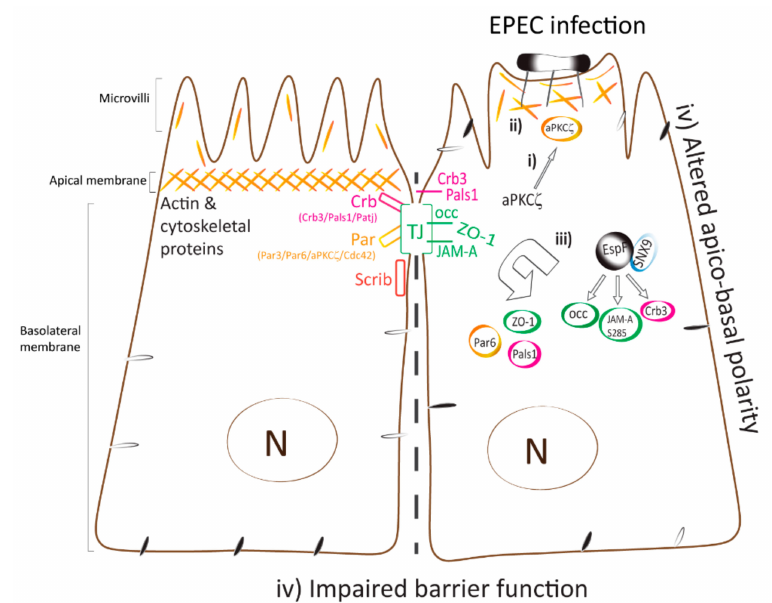
Figure 7. Model displaying the temporal mislocalization of aPKC ζ leading to the dismantling of polarity and TJ complexes. Polarized epithelial cells consist of the apical membrane facing the lumen and the basolateral domain in contact with the underlying basement membrane. TJ, localized at the most apical area of the lateral membrane, contribute to the maintenance of apico-basal polarity. Polarity complexes (Crb, PAR, and Scrib) localize along the lateral membrane and modulate TJ assembly and function. ( i ) EPEC infection induces the recruitment of active aPKC ζ to actin pedestals and at plasma membrane almost immediately upon bacterial attachment. ( ii ) Actin and aPKC ζ are highly organized within EPEC pedestals via a mechanism that is dependent on the EspF / SNX9 binding domain. ( iii ) TJ (JAM-A S285, occludin, and ZO-1) and polarity (Par6, Crb3, and Pals1) proteins are displaced from cell–cell contacts and internalized into the cytoplasm. ( iv ) Apico-basal polarity, evidenced by redistribution of basolateral proteins to the apical membrane [32], and TJ are perturbed. These events are largely dependent on EspF–SNX9 binding domain, although other e ff ectors may